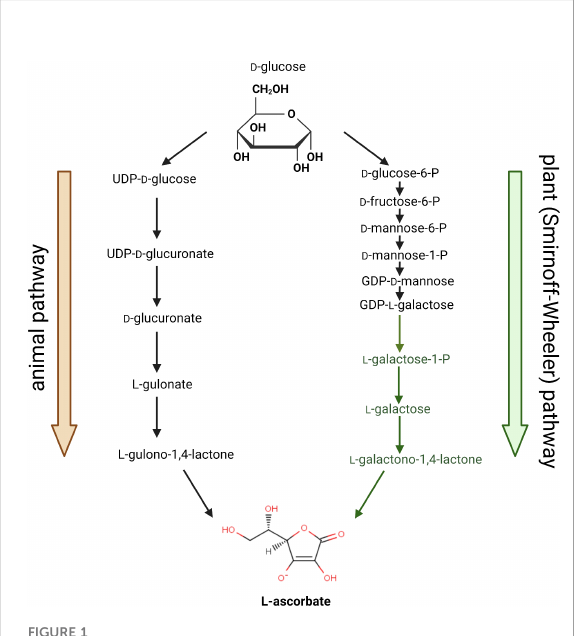
FIGURE 1 Ascorbic acid (AsA) biosynthetic pathways in animals and in plants. The committed steps (speci fi c for AsA synthesis) in the plant pathway are highlighted in